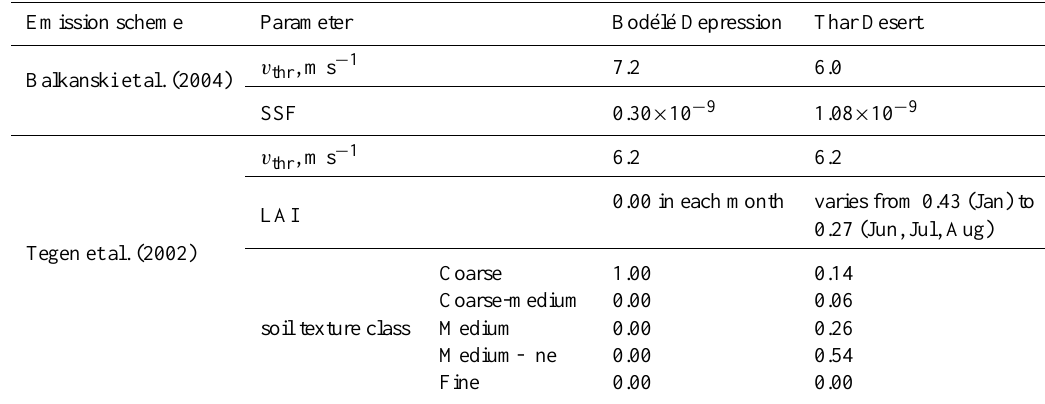
Table 1. Input parameters for the dust emission schemes of Balkanski et al. (2004) and Tegen et al. (2002) for the Bod´el´e Depression and the Thar